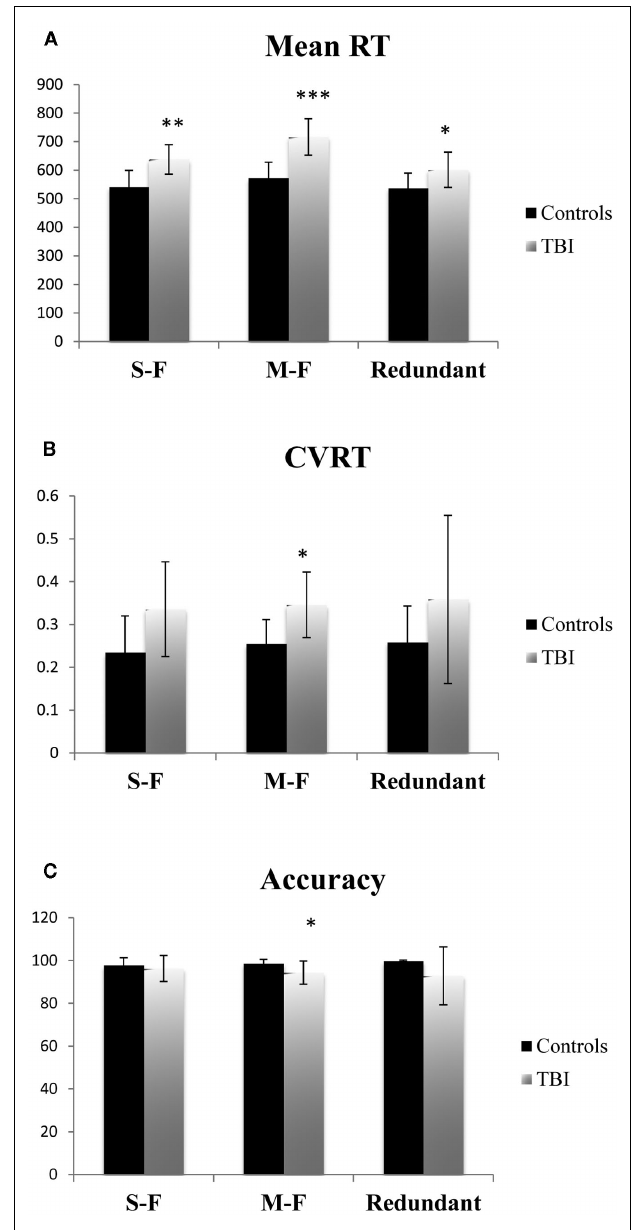
FIGURE 2 | Mean reaction time (RT) (A), coefficient of variation on reaction time (CVRT) (B), and (C) accuracy for each task condition for functional imaging control subjects andTBI patients. Error bars indicate SE of the mean. * = Significant differences between controls andTBI ( p < 0.05). ** = Significant differences between control andTBI ( p < 0.01).